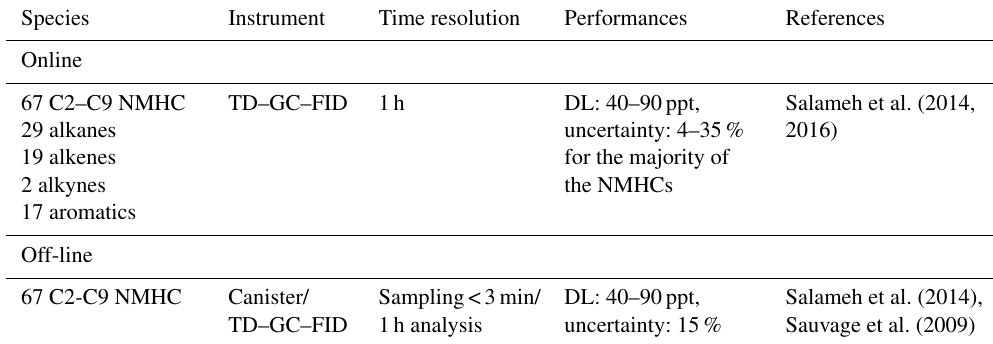
Table 1. Measurements during ECOCEM